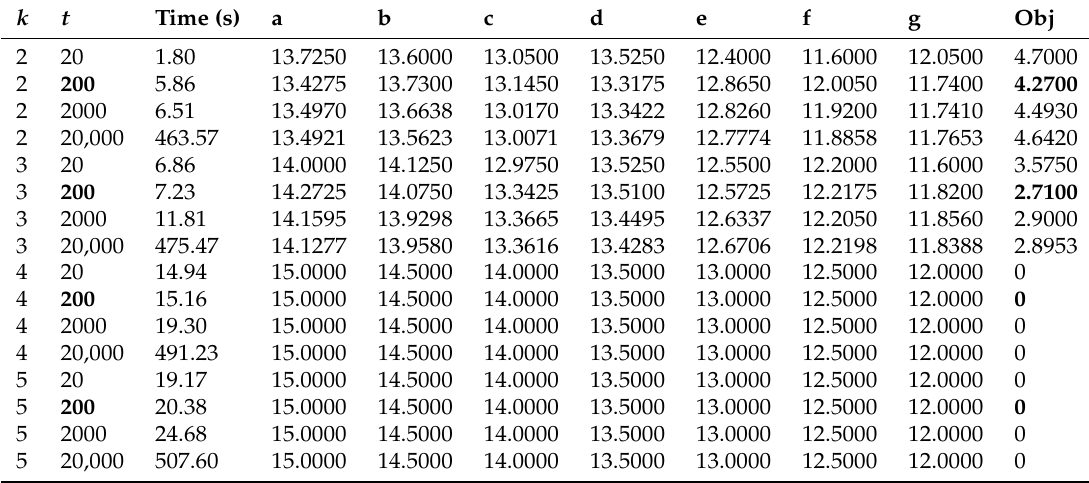
Table 2. Results of Algorithm 1 with different